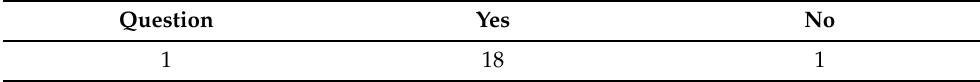
Table 6. Answers to YES/NO questions of the questionnaire.